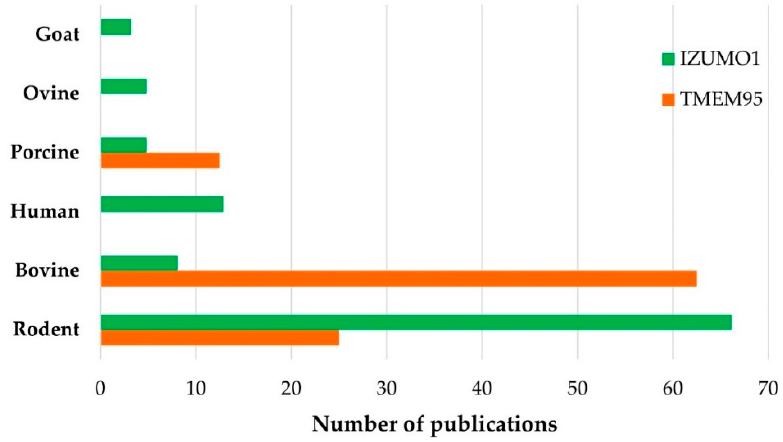
Figure 3. The number of publications according to the species studied in articles for IZUMO1 (green) and TMEM95 (orange).